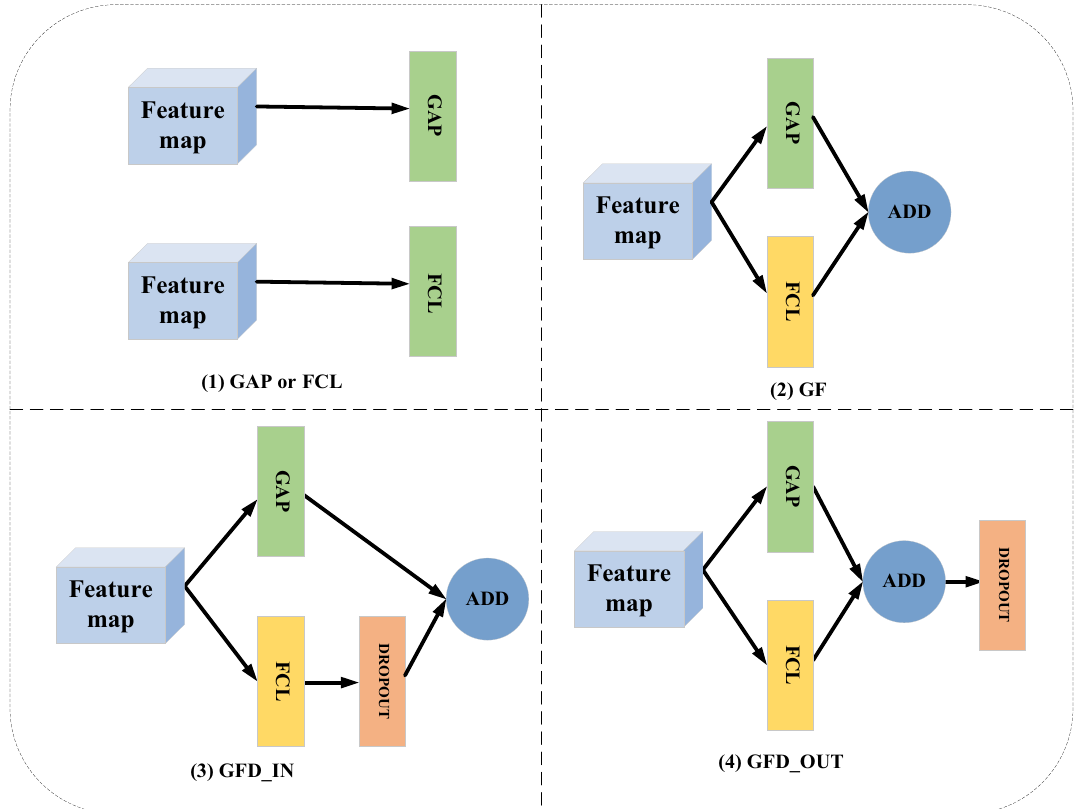
Figure 4. Traditional embedding structure and our residual embedding structure. (1) is the traditional embedding structure and (2) (3) (4) is our proposed residual embedding